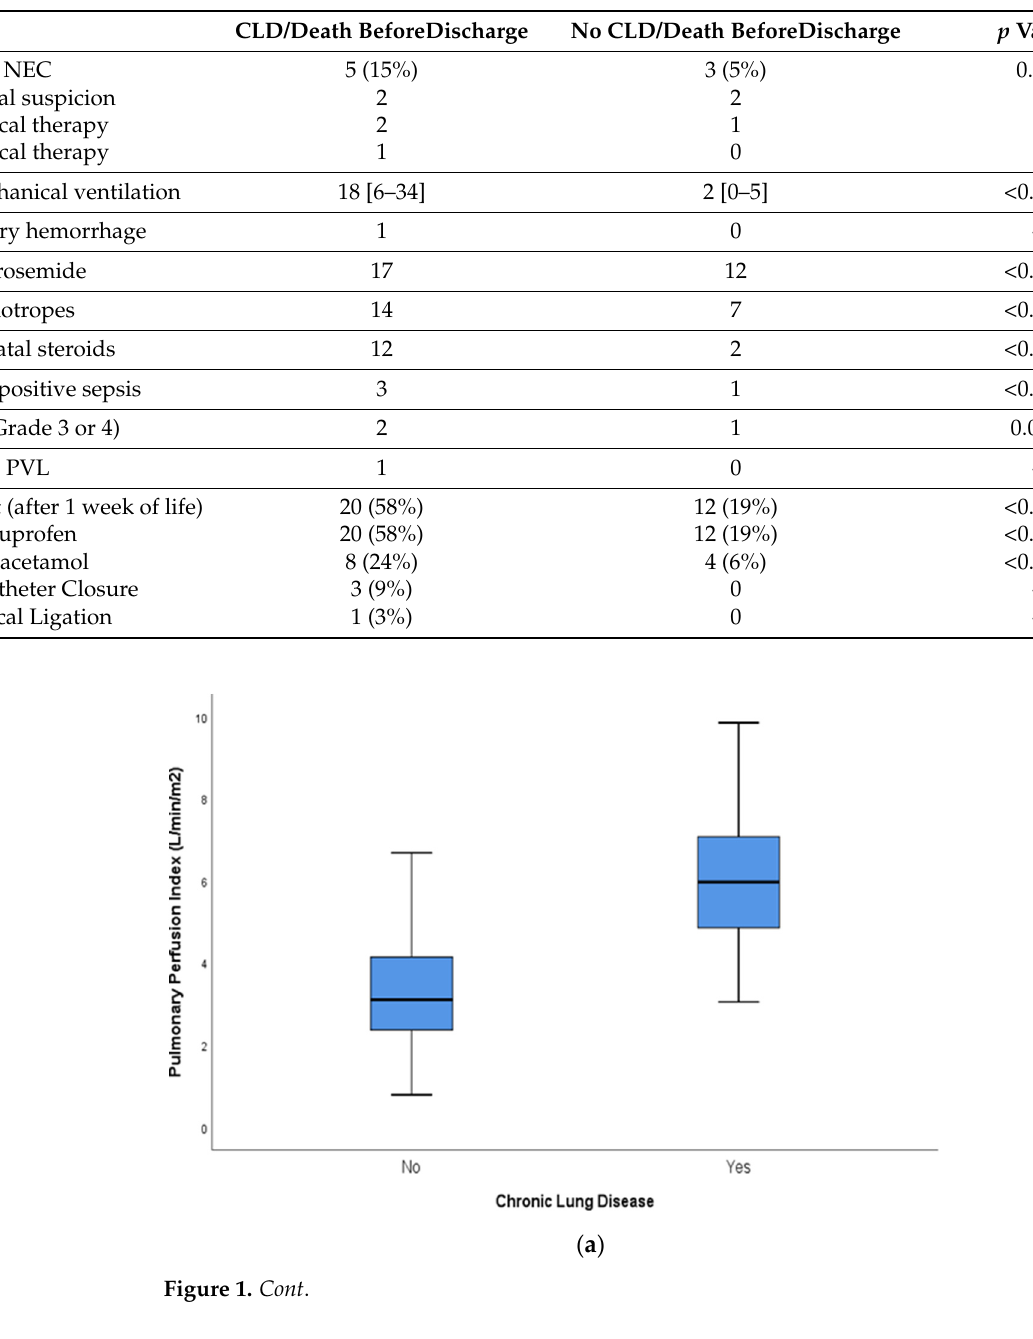
Table 2. Distribution of clinical outcomes and interventions among both groups.